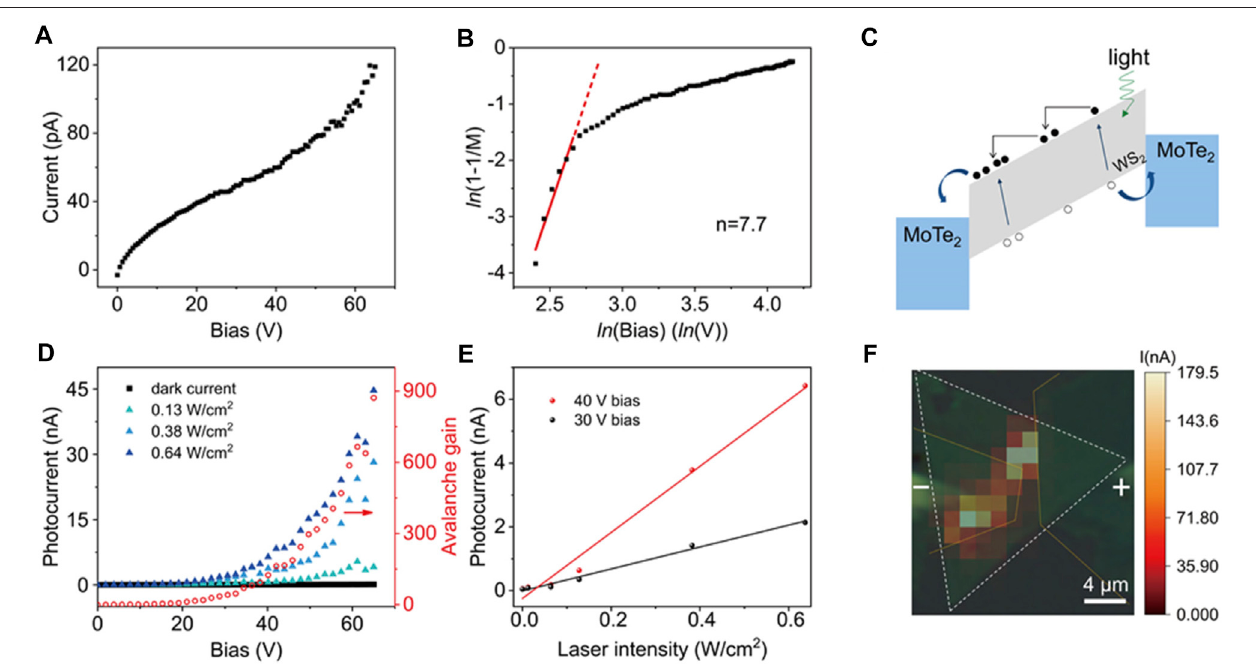
FIGURE 2 | Electrical and photocurrent characterizations of the MoTe 2 – WS 2 – MoTe 2 heterojunction device. (A) Dependence of dark current on bias voltage of the heterojunction device. (B) Relationship between ln(1 − 1/ M ) and ln( V ). M is the multiplication factor. V is the bias voltage. Red dashed line is the linear fi t. (C) Schematic showing the operation principle of the heterojunction device. (D) Photocurrent response of the MoTe 2 – WS 2 – MoTe 2 heterojunction device under different light illumination intensities. Red opened circles show the corresponding AGs upon an excitation intensity of 0.64 W/cm 2 . The illumination wavelength is 532 nm. (E) Intensity-dependentphotocurrentoftheMoTe 2 – WS 2 – MoTe 2 heterojunctiondevice.Theappliedbiasvoltagesare30 V(black)and40 V(red). (F) Photocurrentmapping of MoTe 2 – WS 2 – MoTe 2 heterojunction device. White dashed lines mark out the WS 2 region. Yellow solid lines mark out the MoTe 2 region. Symbols “ + ” and “ − ” indicate the direction of the bias